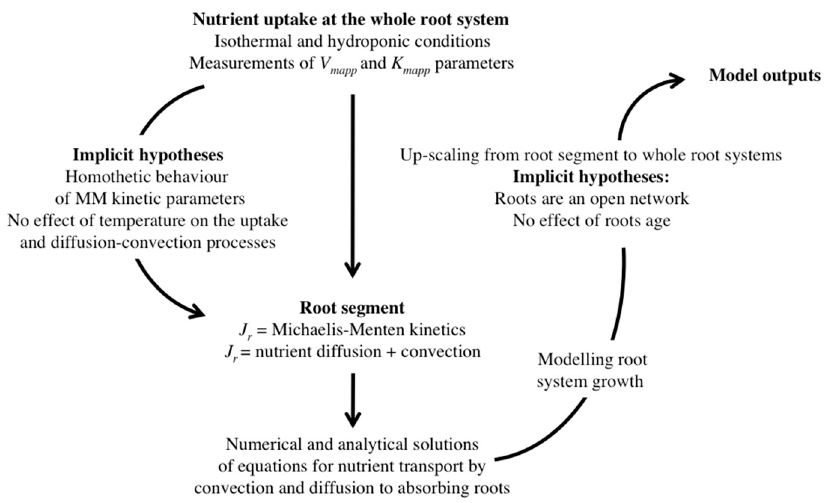
Figure 1. Implicit hypotheses used for building nutrient uptake models from Michaelis–Menten (MM)-type relation and convection–diffusion of nutrients toward the roots (adapted from [2–5]).